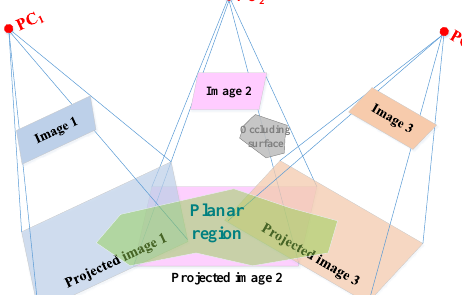
Figure 7. A planar region which is partially visible in the overlapping